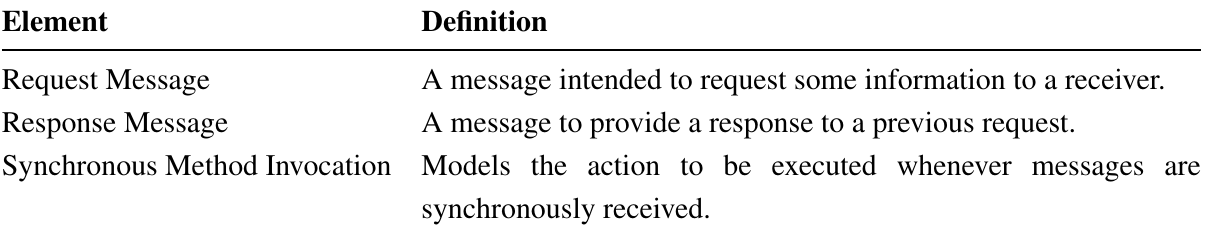
Table 3. Definition of the elements of the specialized model to support RR